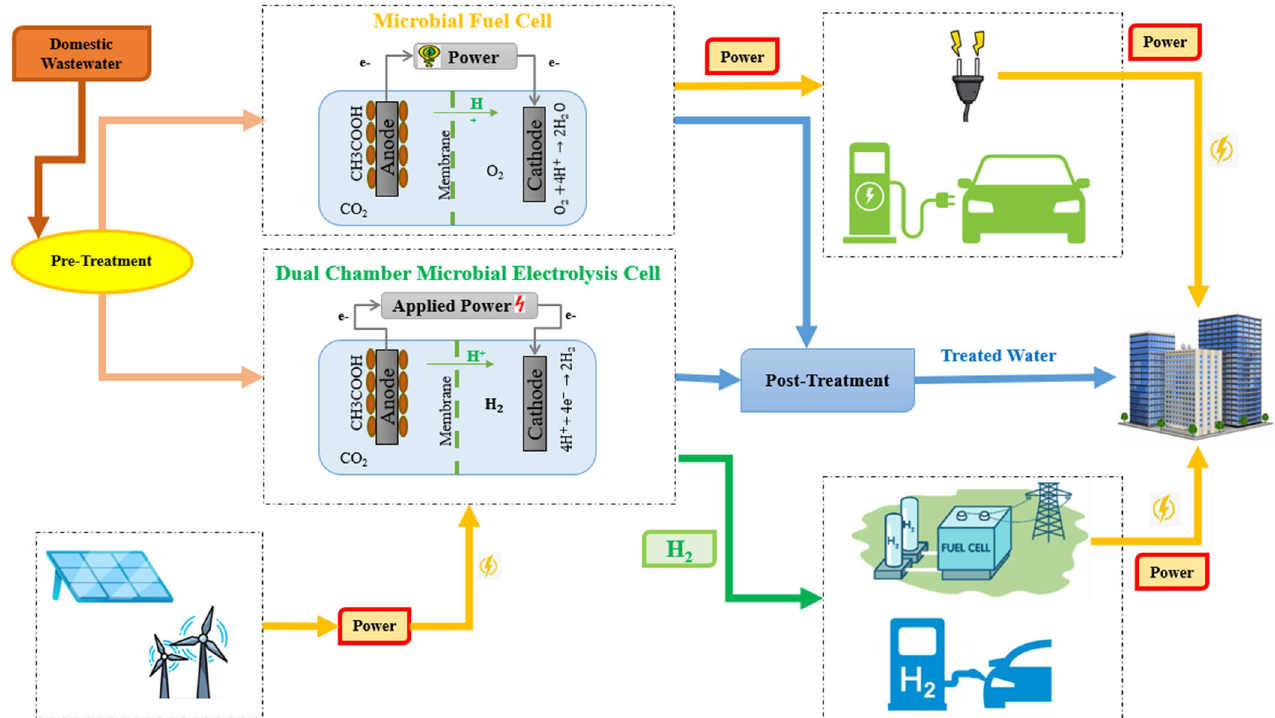
Figure 6. The schematics of the proposed advanced wastewater treatment system.